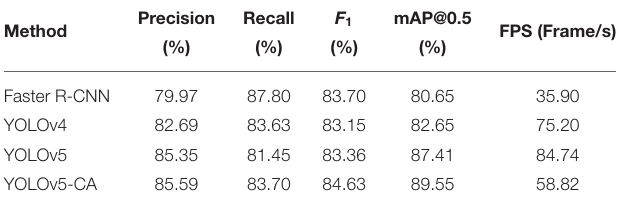
TABLE 1 | Comparison of different GDM